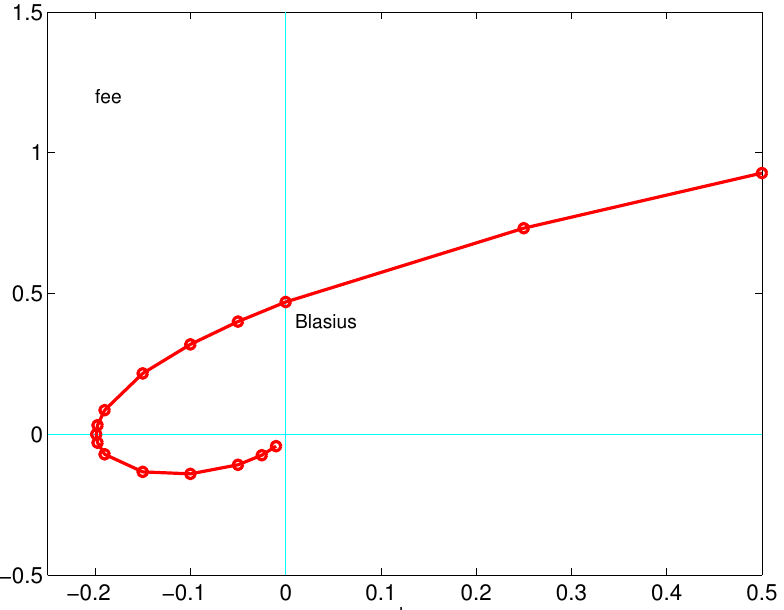
Figure 6. Missing initial conditions to Falkner–Skan model for several values of β . Positive values determine normal flow, and instead, negative values define reverse flow solutions.